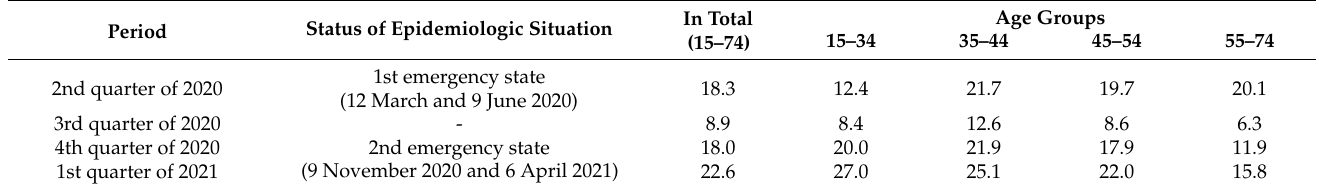
Table A1. Percentage of teleworkers (%) in Latvia by age groups, 2020 and 2021. Period Status of Epidemiologic